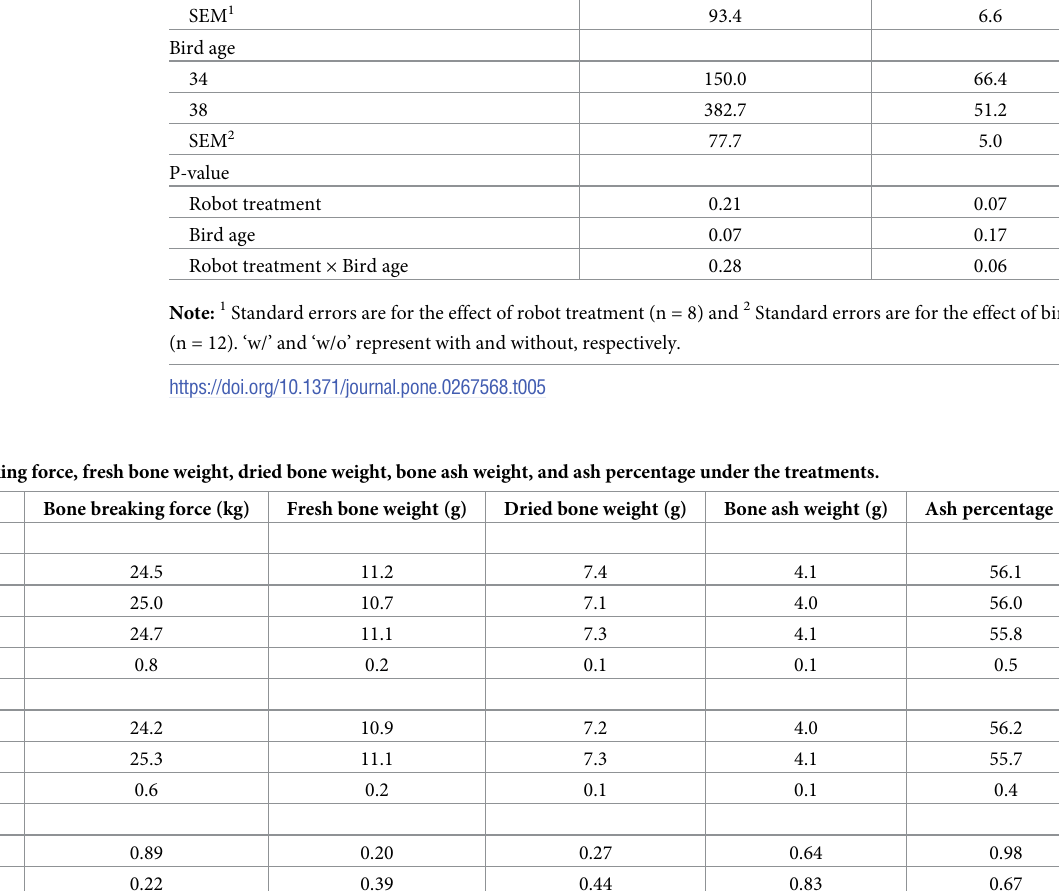
Table 5. Mean and coefficient of variations (CV) of serum corticosterone concentrations.